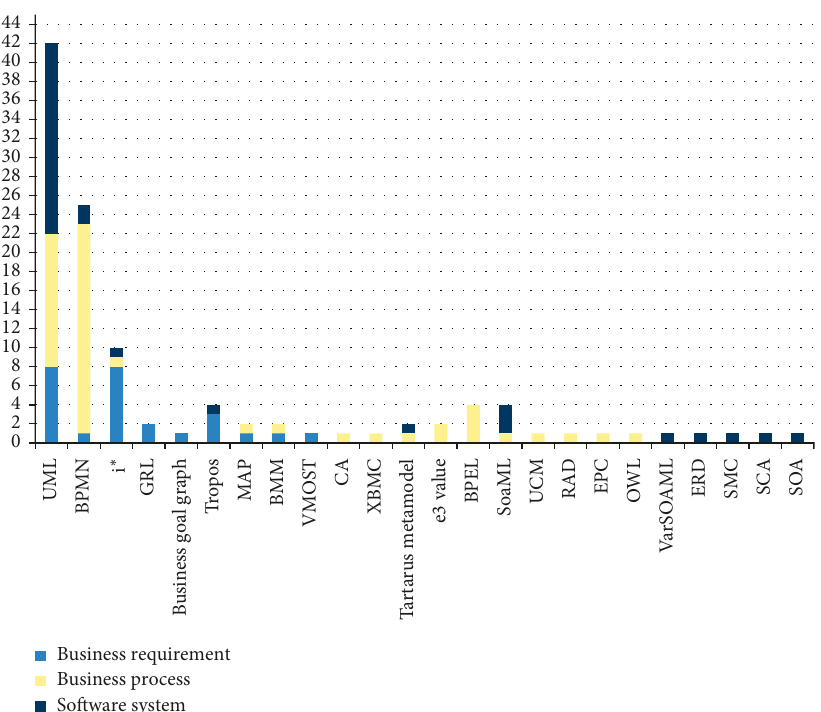
Figure 6: Number of models used at each